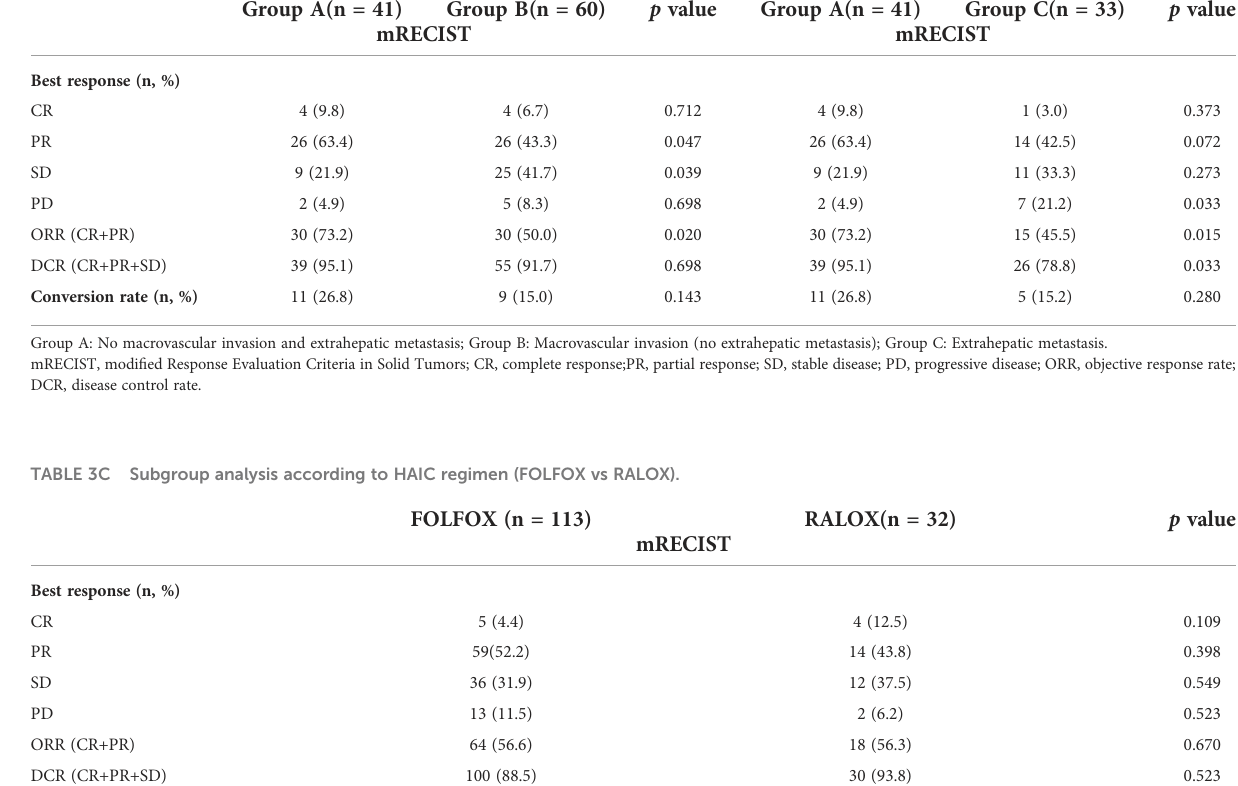
FOLFOX: HAIC with oxaliplatin, 5- fl uorouracil, and leucovorin; RALOX: HAIC with raltitrexed plus oxaliplatin; mRECIST, modi fi ed Response Evaluation Criteria in Solid Tumors; CR, complete response; PR, partial response; SD, stable disease; PD, progressive disease; ORR, objective response rate; DCR, disease control rate.